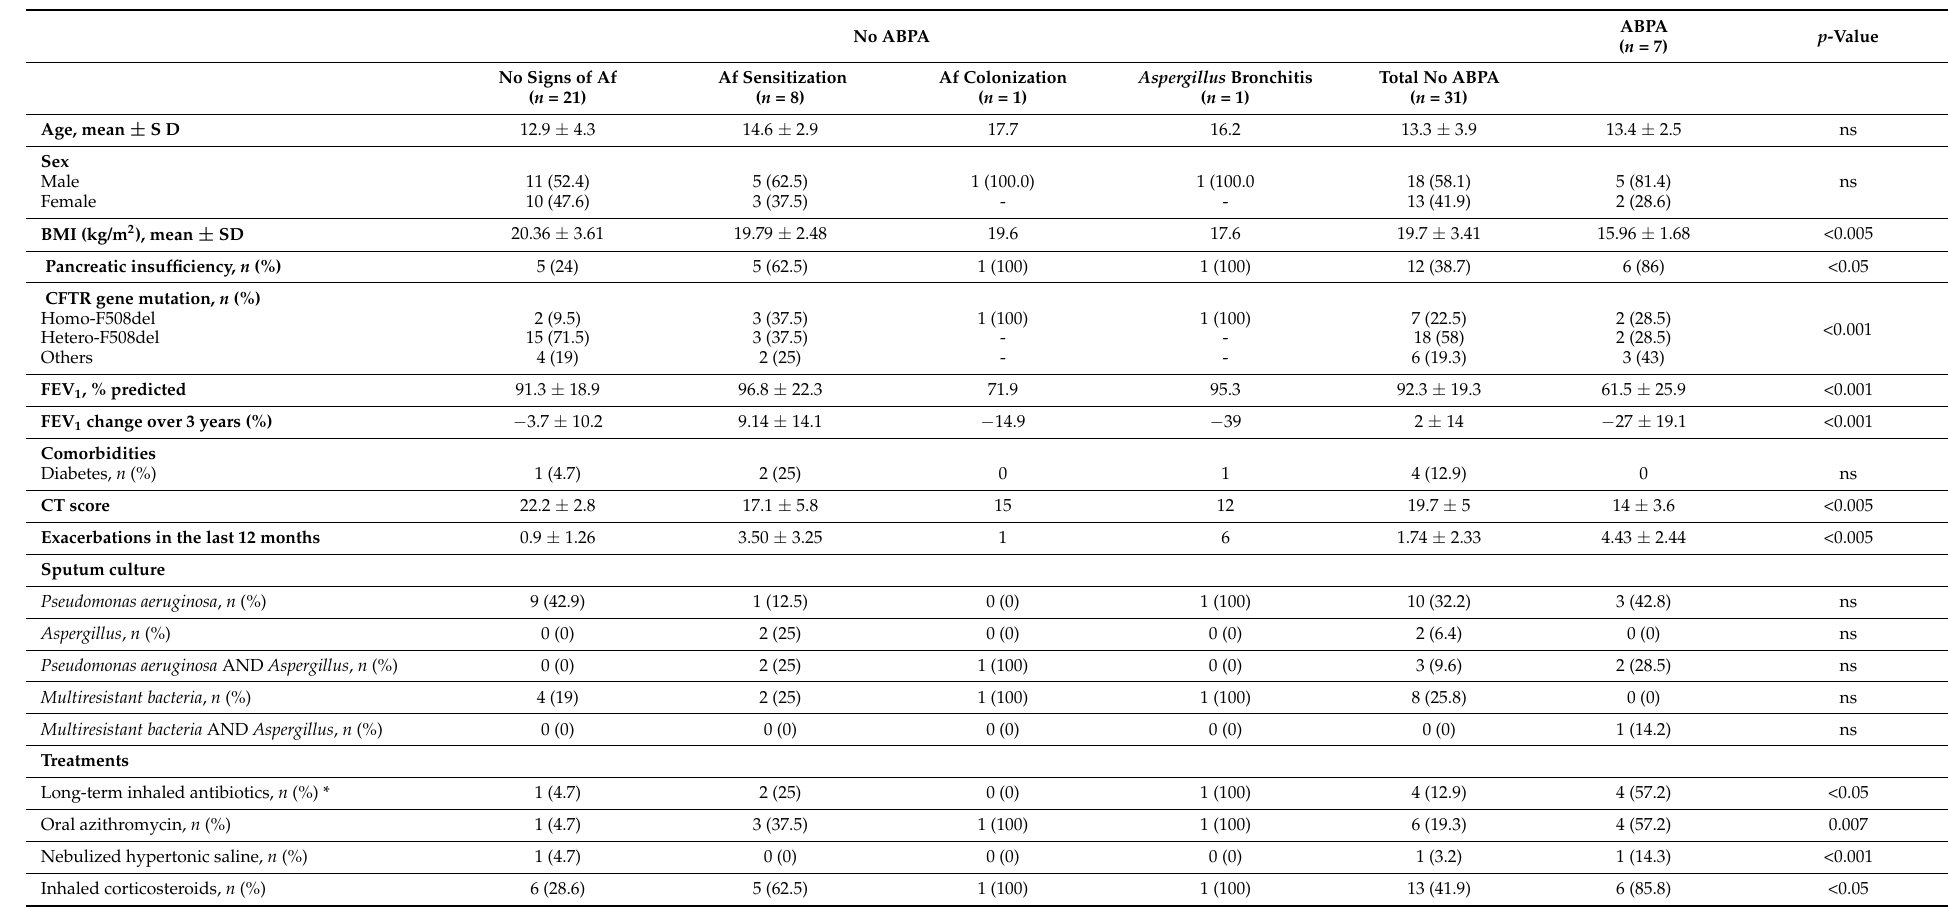
Table 1. Characteristics of patients at time of enrollment. All values are expressed as mean ±